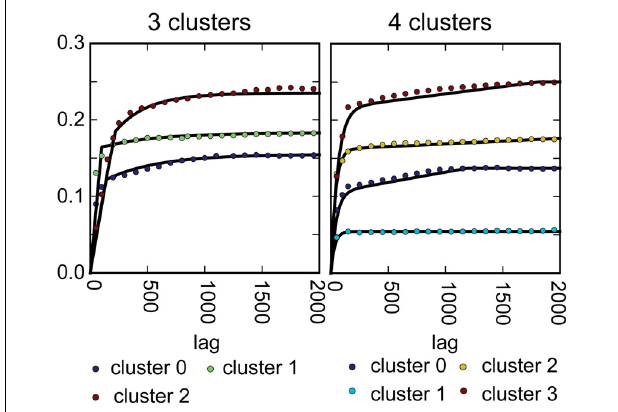
FIGURE 4 | Indicator variograms fitted to the 3 and the 4-cluster dataset.